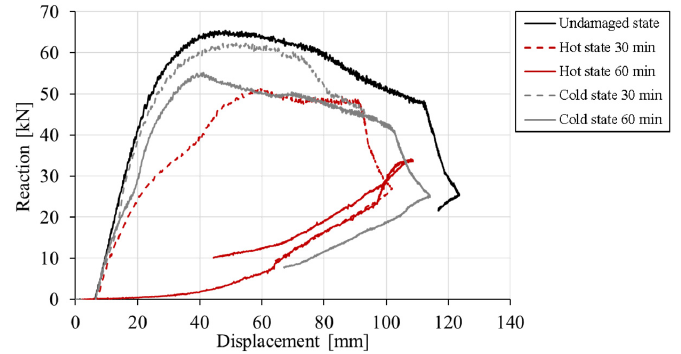
Table 2. Summary peak reactions for static and dynamic analysis.